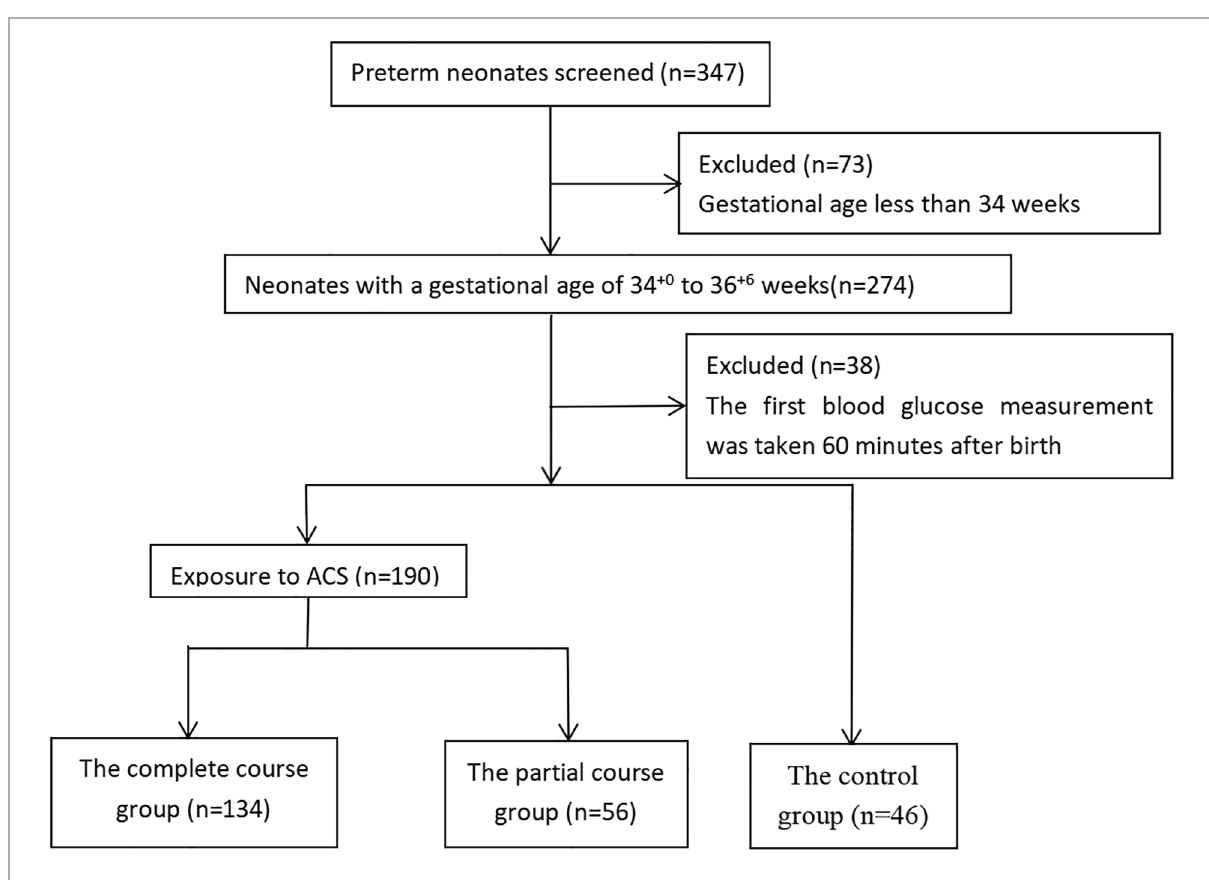
FIGURE 1 Study participants fl